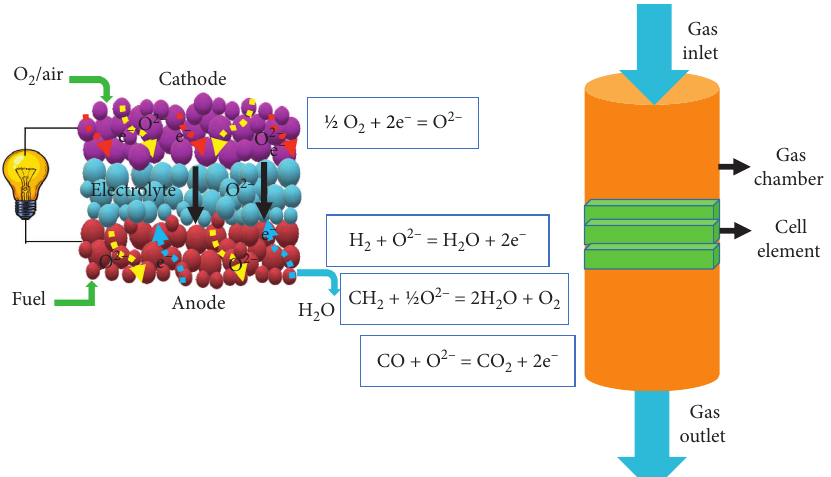
Figure 1: Schematic illustration of the all porous single-chamber SOFC. Methane (CH introduced at the cathode and conveyed by the permeable electrolyte to the catalytic